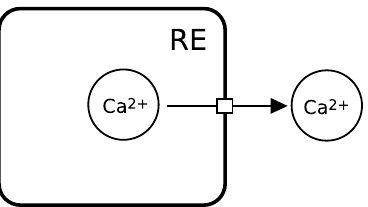
Figure 2.28: Translocation of calcium ion out of the endoplasmic reticulum. Note that the process does not have to be located on the boundary of the compartment . A process is not attached to any compartment